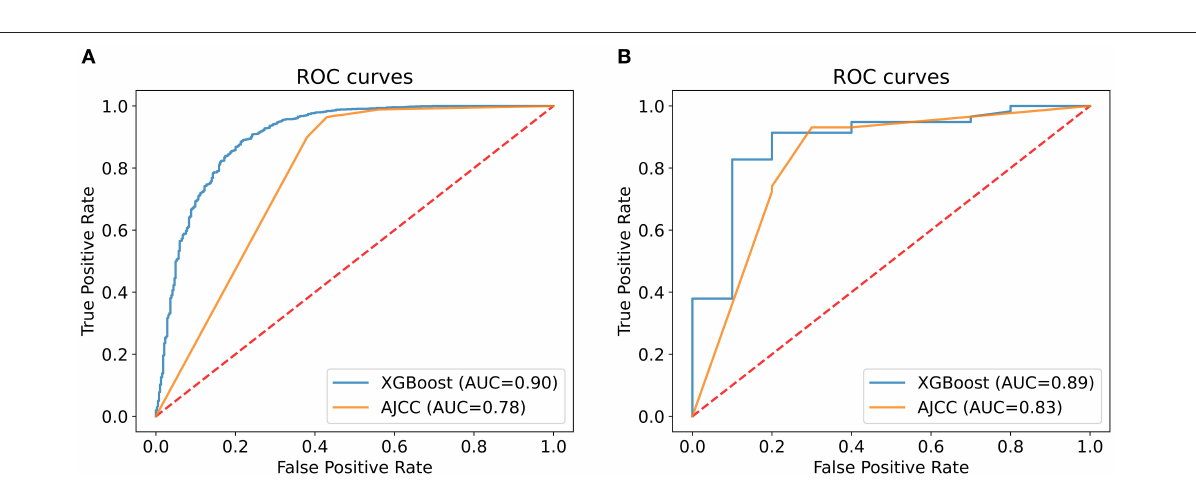
AJCC seventh staging system (AUC = 0.83, 95% CI: 0.66–0.99) ( Figure 4 ; Table 5 ). In addition, more patients were correctly classified by the machine learning predictive model (NRI = 0.190, 95%CI: 0.089–0.291, P <